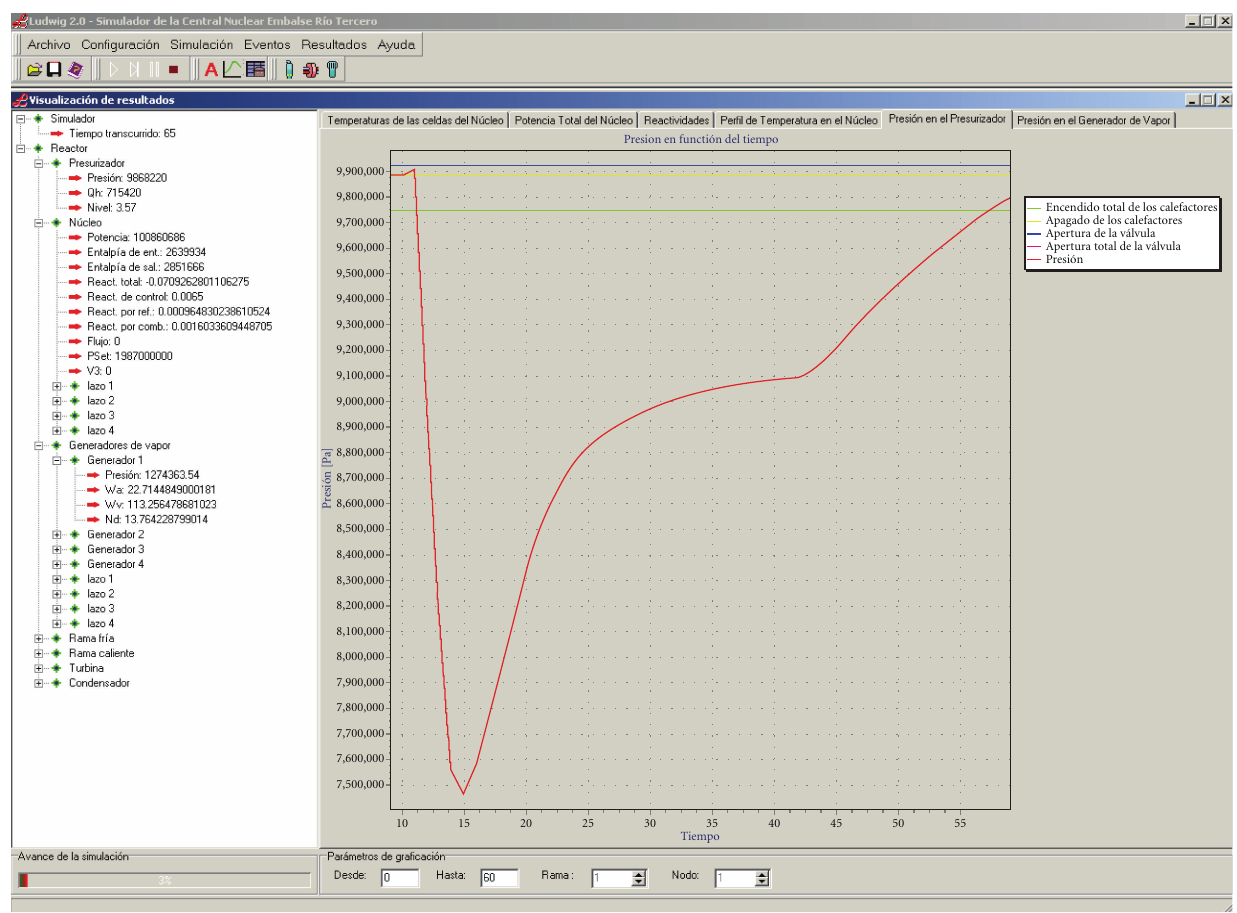
Figure 2: Ludwig graphic window. Tree of variables (left) and display of data (right).